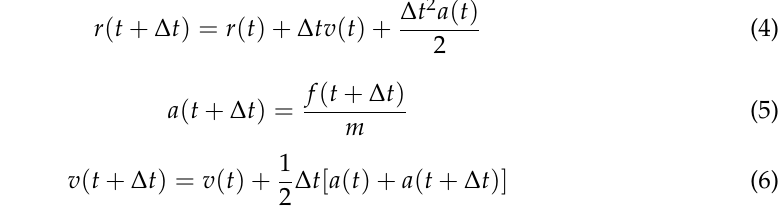
( b ) Figure 6. Self-aggregation equilibrium configuration of the system: ( a ) Self-aggregation process, ( b ) self-assembled membrane configuration. 3.2. Density Profile The alkyl groups in the modified molecules are mixed with the oil phase, and the GO molecules are distributed on the water phase interface because of the polar group -OH. As shown in Figure 6, the oil and water phases are regularly separated by the modified nanoparticle NGOs. To more intuitively observe the self-assembled structure of the NGOs